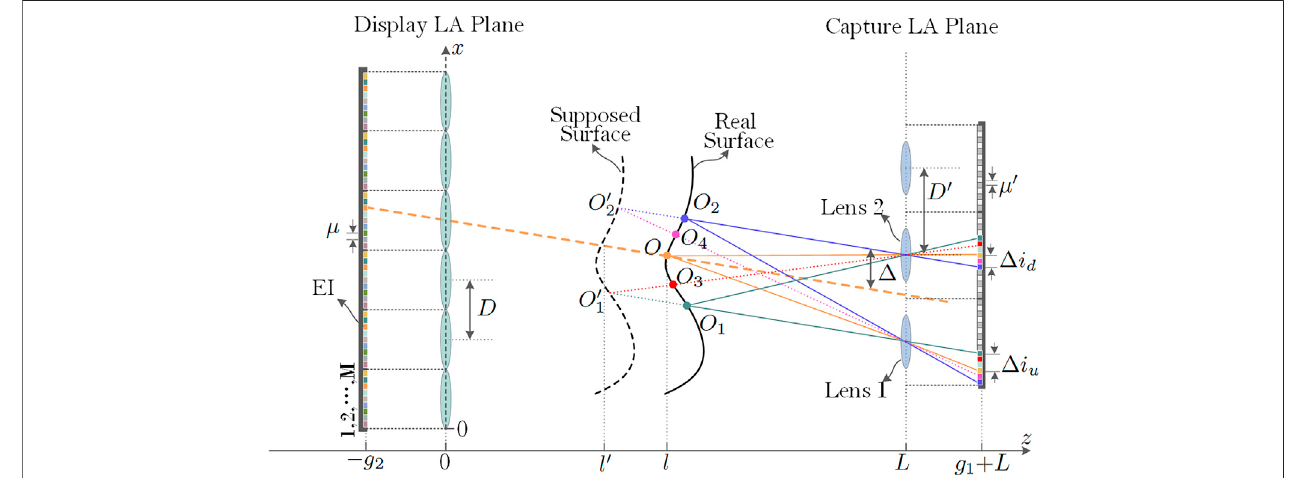
FIGURE 5 | Errors in capture and display rays.